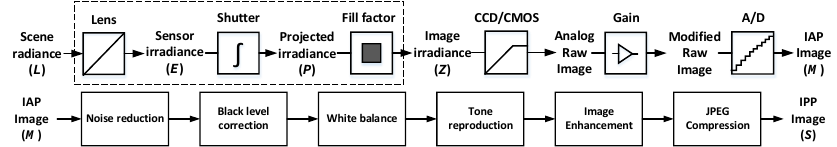
Figure 1. The image acquisition pipeline ( top ) and the image processing pipeline ( bottom ). The image acquisition pipeline shows the process of how scene radiance ( 𝐿 ) becomes digital pixel values in an IAP image 𝑀 , and the image processing pipeline shows the process of how an IAP image ( 𝑀 ) can be processed further to obtain an IPP image ( 𝑆) . (M, L and S are in italic in the text, but in normal in the figure 1. Please change them to be in italic.